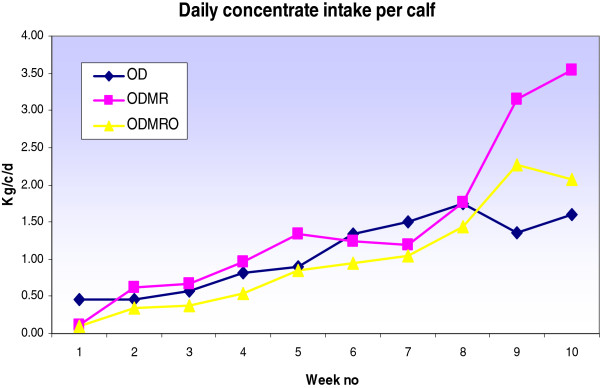
Calf intake of concentrates per day-Experiment 2.